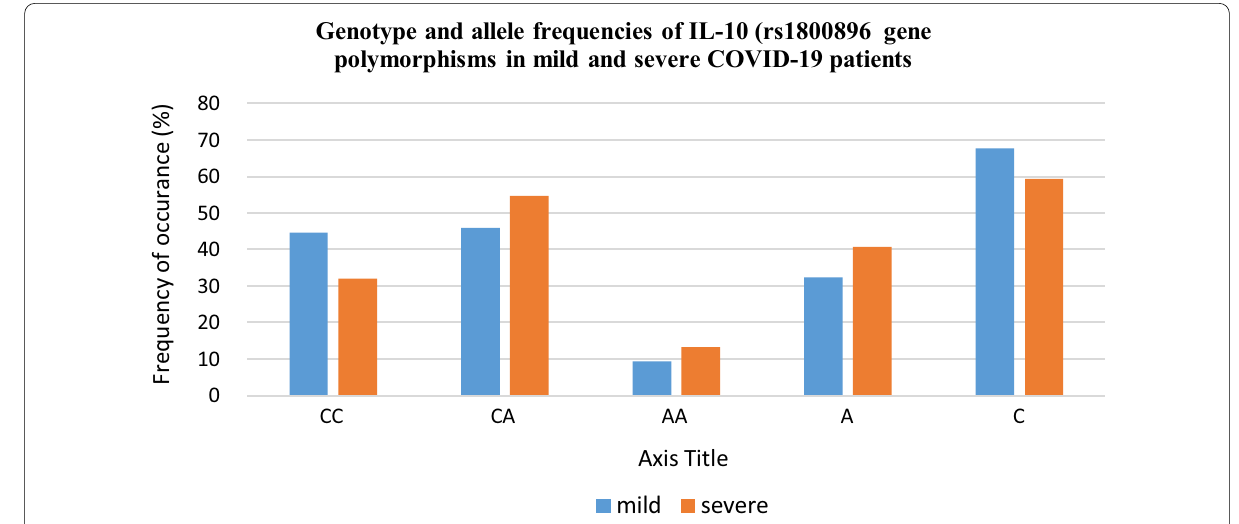
Fig. 1 Graphical representation of genotype and allele frequencies of IL-10 rs1800872 gene polymorphisms in COVID-19 patients